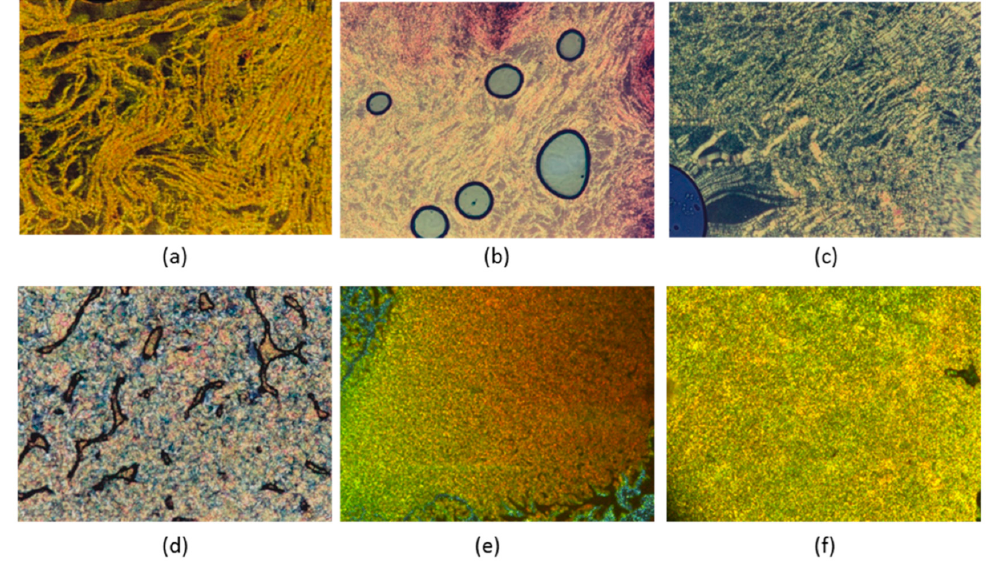
Figure 2. POM photomicrographs of: ( a ) BF 4 -12 at 114 °C on cooling; ( b ) ReO 4 -12 at 104 °C on cooling; ( c ) CF 3 SO 3 -14 at 148 °C on cooling; ( d ) NO 3 -12 at 112 °C on cooling; ( e ) CuCl 4 -12 at 158 °C on heating; ( f ) CuCl 4 -18 at 111 °C on cooling.